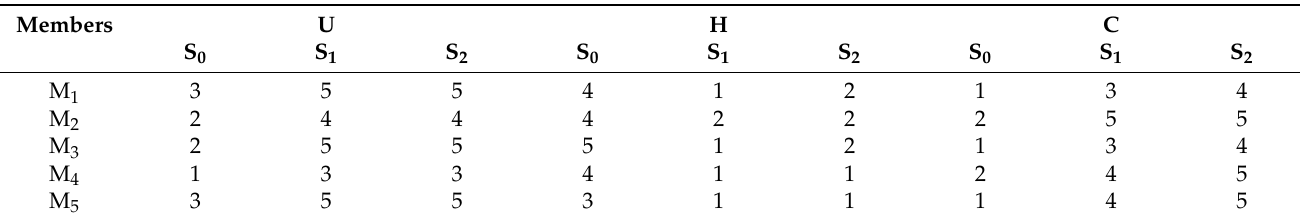
Table 3. Solution